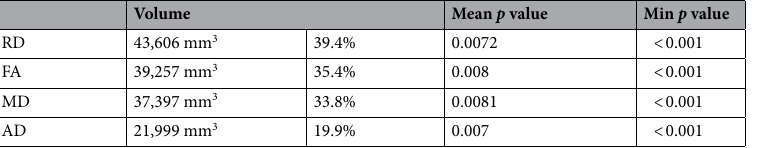
Table 2. Parameters of the analysis of clusters of the permutation testing for each diffusion tensor parameter. The parameters of the clusters listed are volume in mm 3 and in % compared to the total WM tracts volume (of 110,750 mm 3 ), mean p value and min p